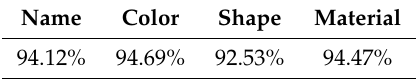
Table 4. Recognition accuracy of object attributes on the test